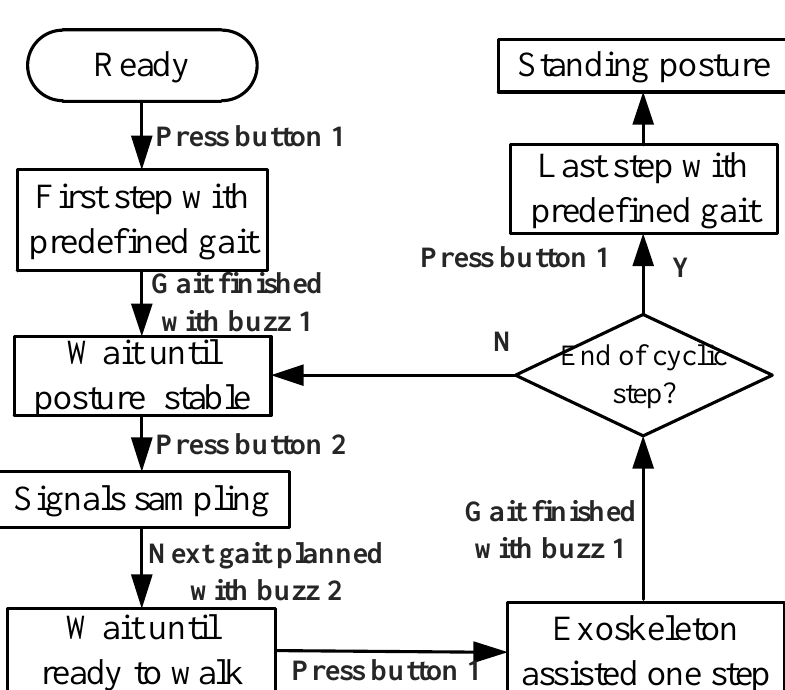
Figure 9. Exoskeleton-assisted walking test procedure. The subject was told to press buttons 1 and 2 before walking and signal sampling, respectively. The subject was reminded with buzz 1 that the current gait was finished, and with buzz 2 that signal sampling was completed. The gaits of the first and last steps were predefined and independent of CoP.